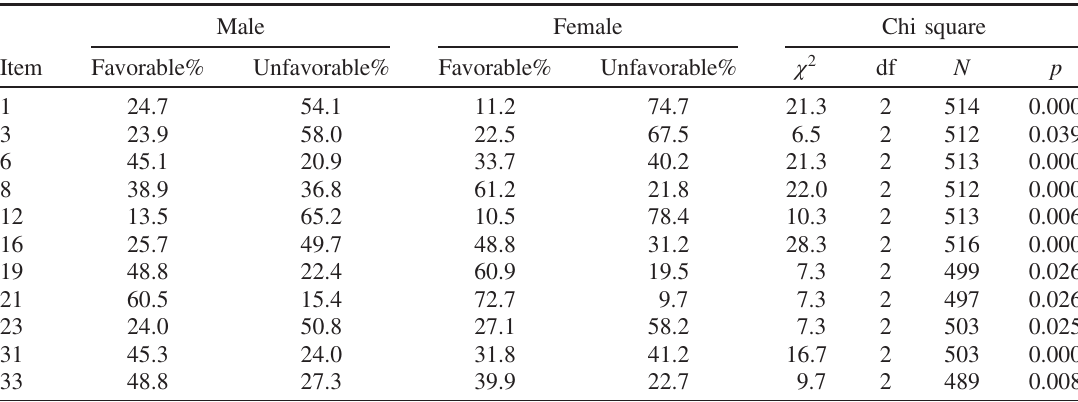
TABLE III. Percentages of male and female students ’ favorable and unfavorable attitudes and approaches to problem solving and the corresponding chi-square statistics for items on which there is a statistically significant